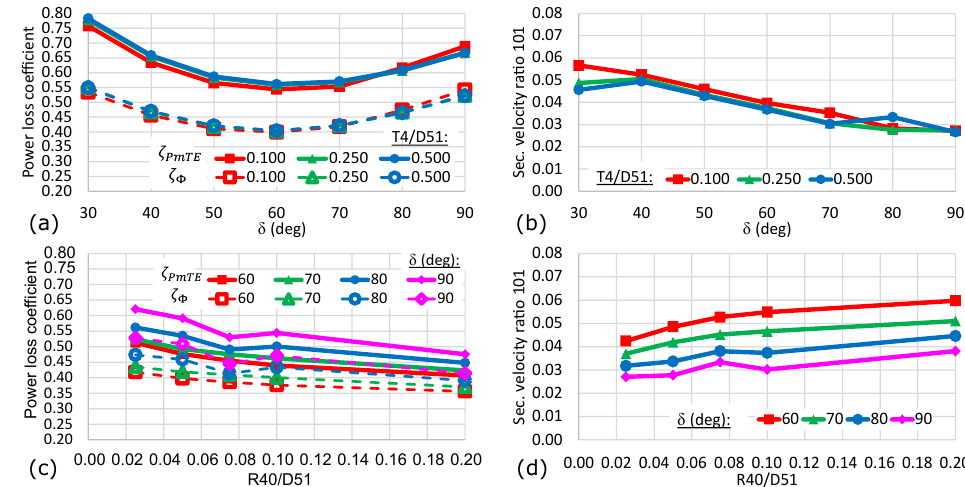
Figure 9. Line plots of the power loss coefficients and secondary velocity ratios of the model with cylindrical manifold. Charts ( a , b ) show the effect of a variation of the deviation angle δ for different axial positions T 4 / D 51 of the branch line. Charts ( c , d ) show the effect of applying a fillet of radius R 40 / D 51 to smooth the connection between the cylindrical manifold and the branch lines for four different deviation